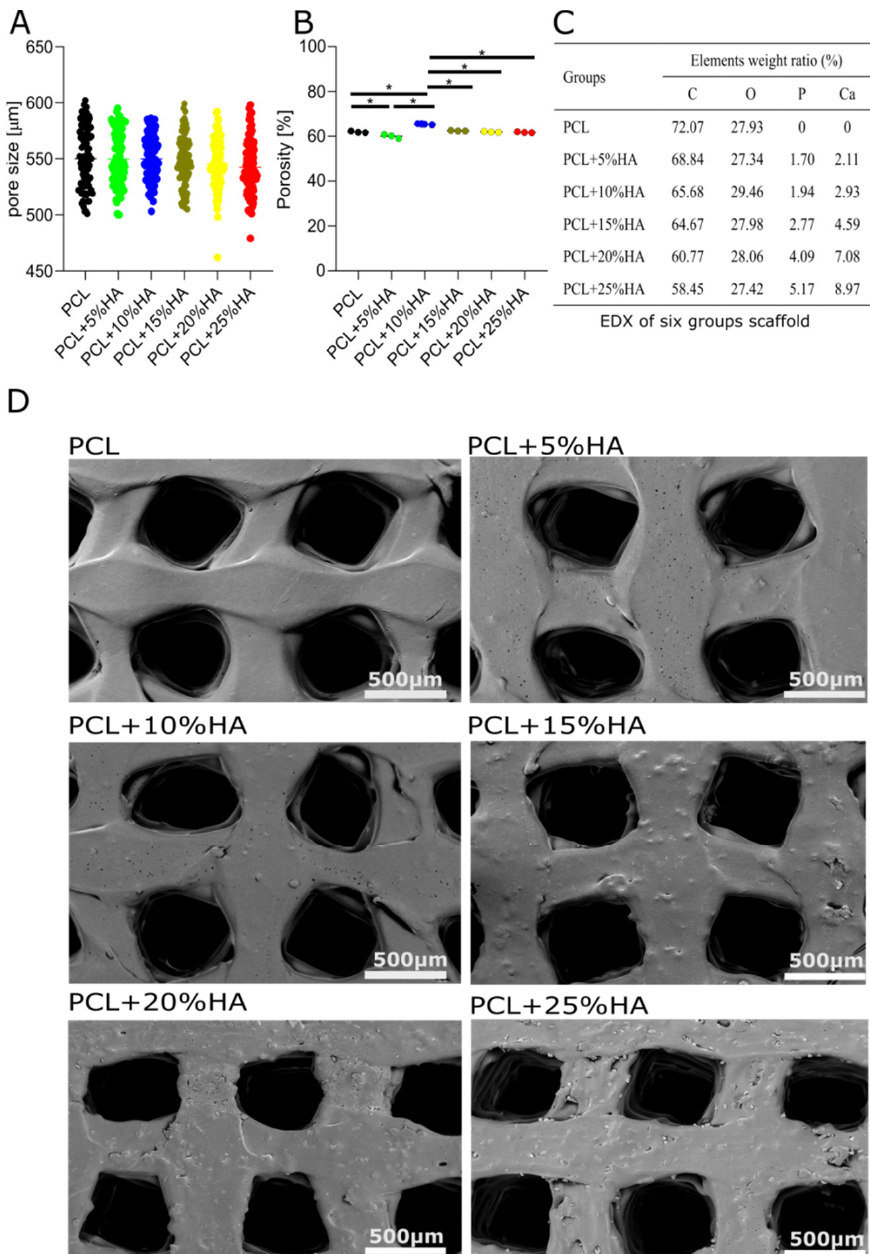
Figure 3. Surface characterization of the scaffolds. ( A ) The pore size of the six groups of scaffolds (mean ± s.e.m); 90 measurements of 3 scaffolds in each group (one-way ANOVA + Tukey’s post hoc test, n.s. = p > 0.05). ( B ) Porosity was calculated based on the weight of the scaffolds. The graph represents the mean ± s.e.m (one-way ANOVA + Tukey’s post hoc test, * = p < 0.05, n = 3). ( C ) Energy-dispersive X-ray spectroscopy (EDX) of the different groups (complete scaffold surface scanning). ( D ) Scanning electron microscopy (SEM) image of the surface of the scaffolds. HA granules are visible in the structure: scale bar = 500 μ m.